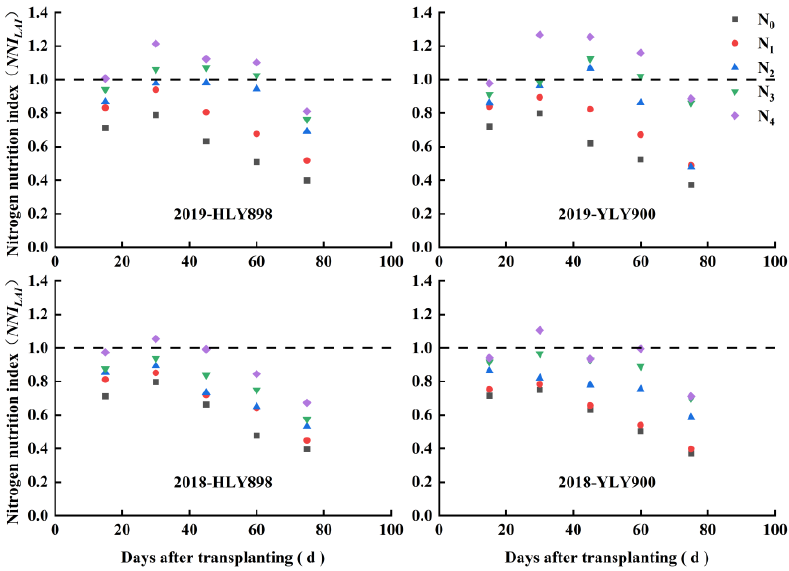
Figure 7. Dynamic changes in NNI LAI according to days after transplanting (d) shown for the varieties Huiliangyou 898 (HLY 898) and Yliangyou 900 (YLY 900) according to the season (2018 or 2019).